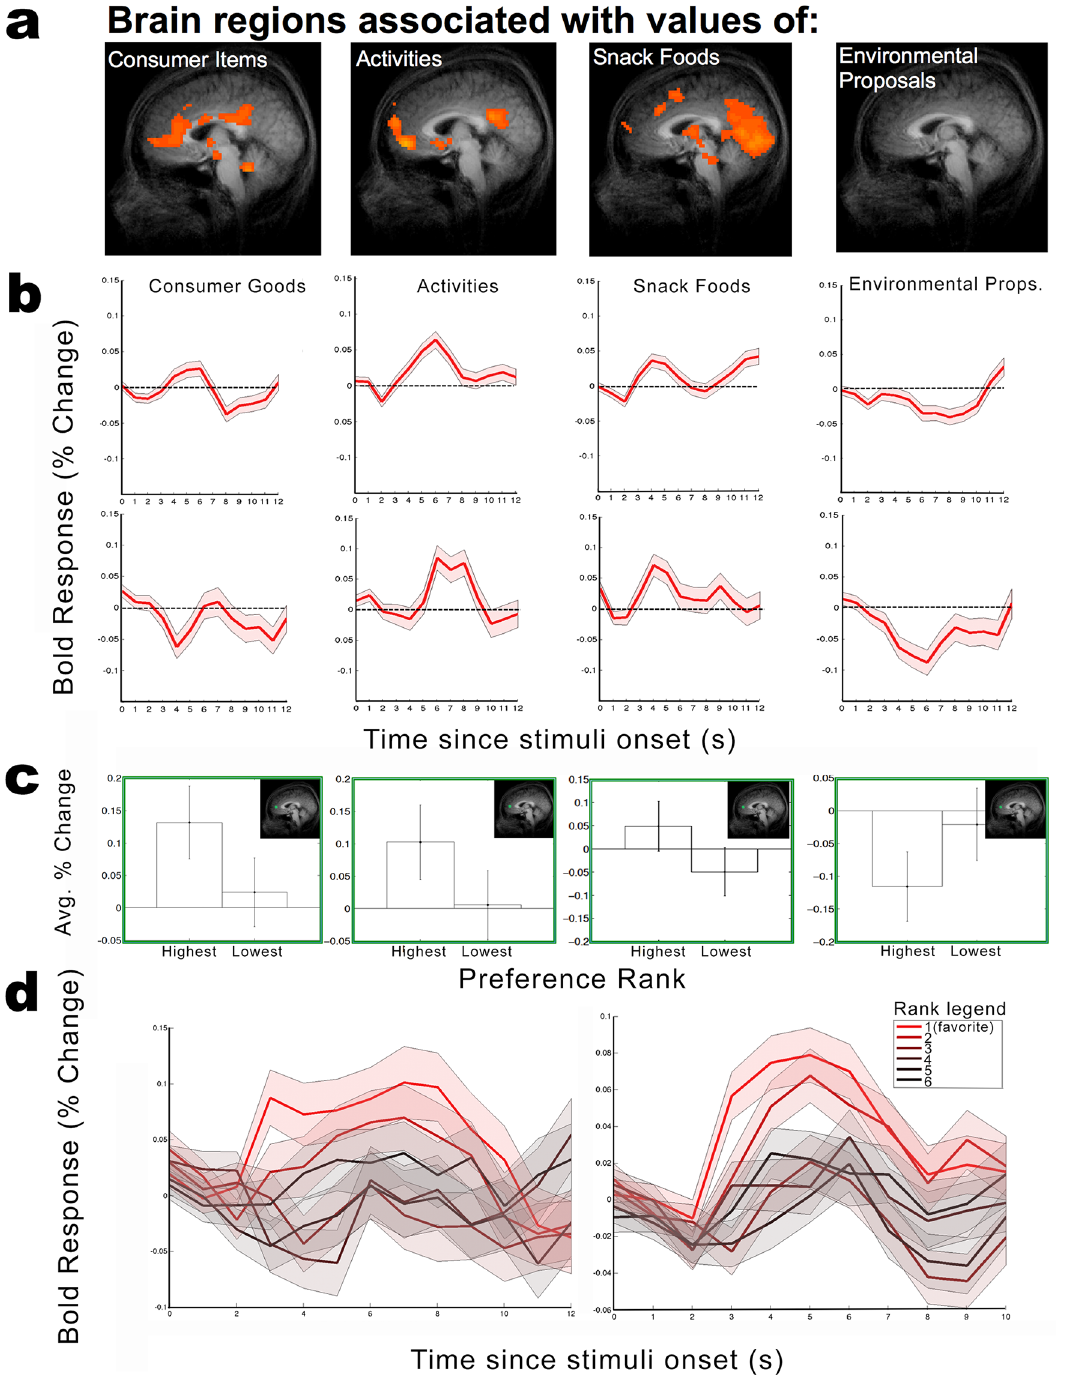
Fig 6. (a) Statistical parameter maps revealing regions associated with subjective value of different categories of goods (p < 0.05, uncorrected). (b) Average time course following the onset of each trial type for spherical ROIs centered on the ventral striatum (top) and vmPFC (bottom). (c) Average time course averaged according to good rank from the vmPFC (left) and ventral striatum (right). (d) Differential activity within vmPFC region of interest (inset) for highest and lowest ranked goods (error bars indicates ± s.e. of the mean). Inset: spherical vmPFC ROI used to compute average change BOLD activity between time points 5 – 8 after stimuli